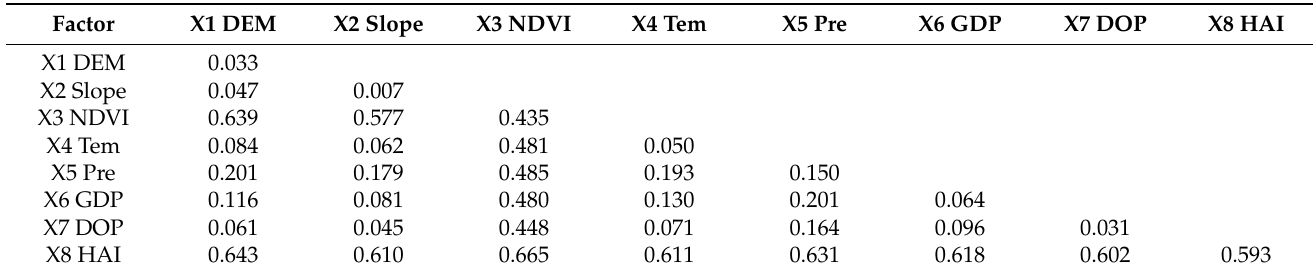
Table 6. Factor Interaction Detection for the Spatial Differentiation of